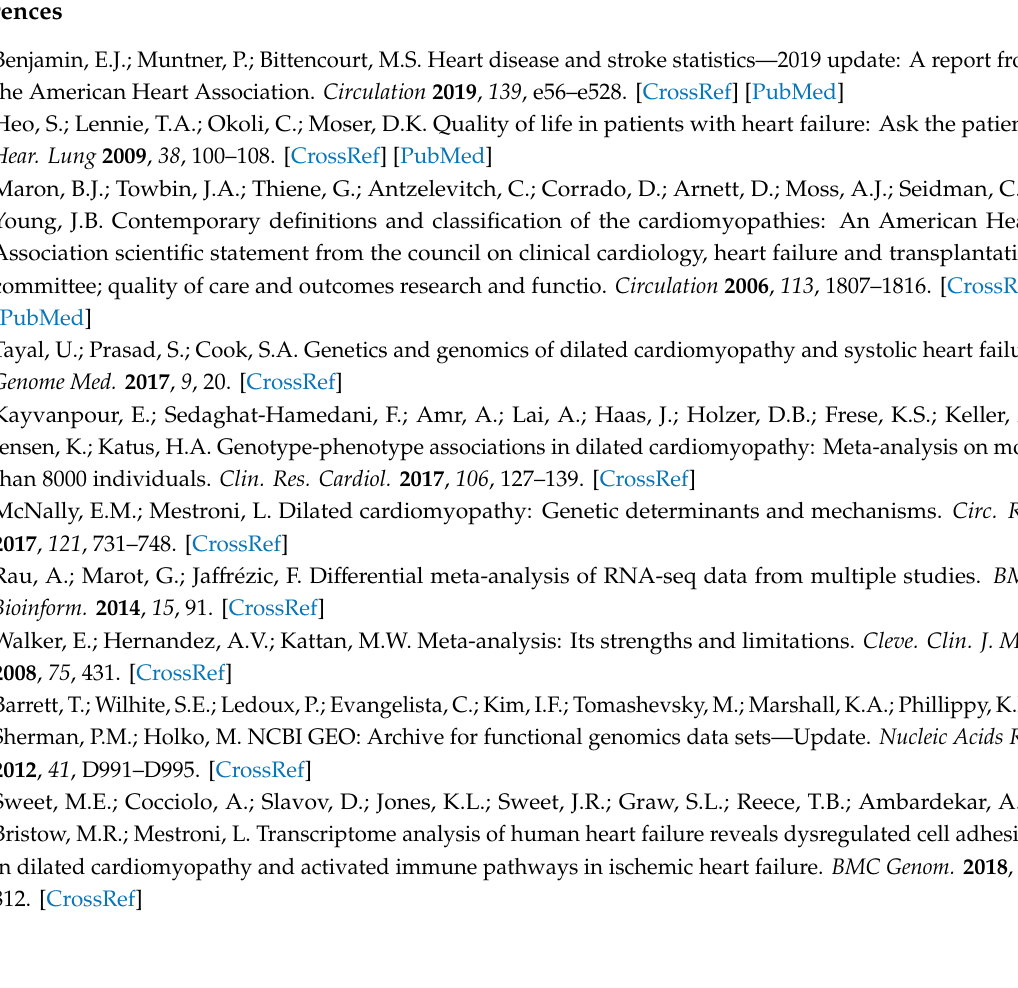
Table S1: A complete list of di ff erential expressed genes identified in meta-analysis of DCM vs NF. Table S2: Di ff erentially expressed upstream regulators and their target genes. Table S3: Significant canonical pathways with absolute z-score > 2.0 and the involved